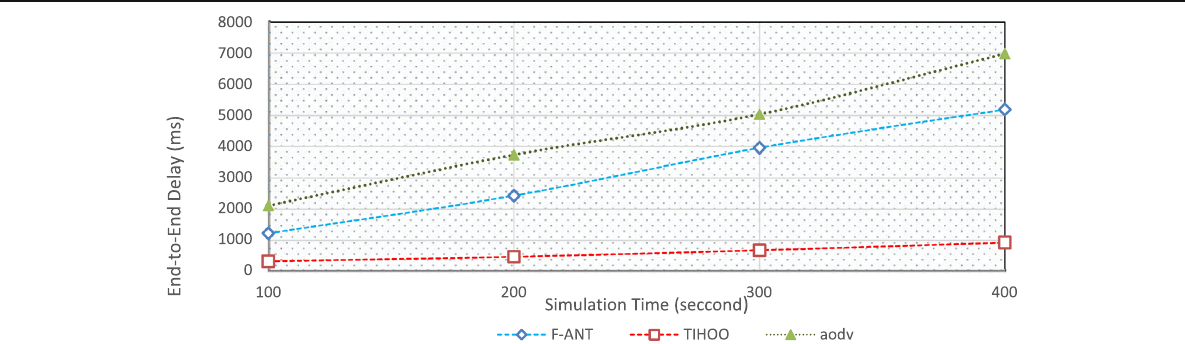
Fig. 12 End-to-end delay based on simulation time. The simulation results for end-to-end delays are assessed based on the simulation time. The CS algorithm which has a fast convergence rate has improved end-to-end